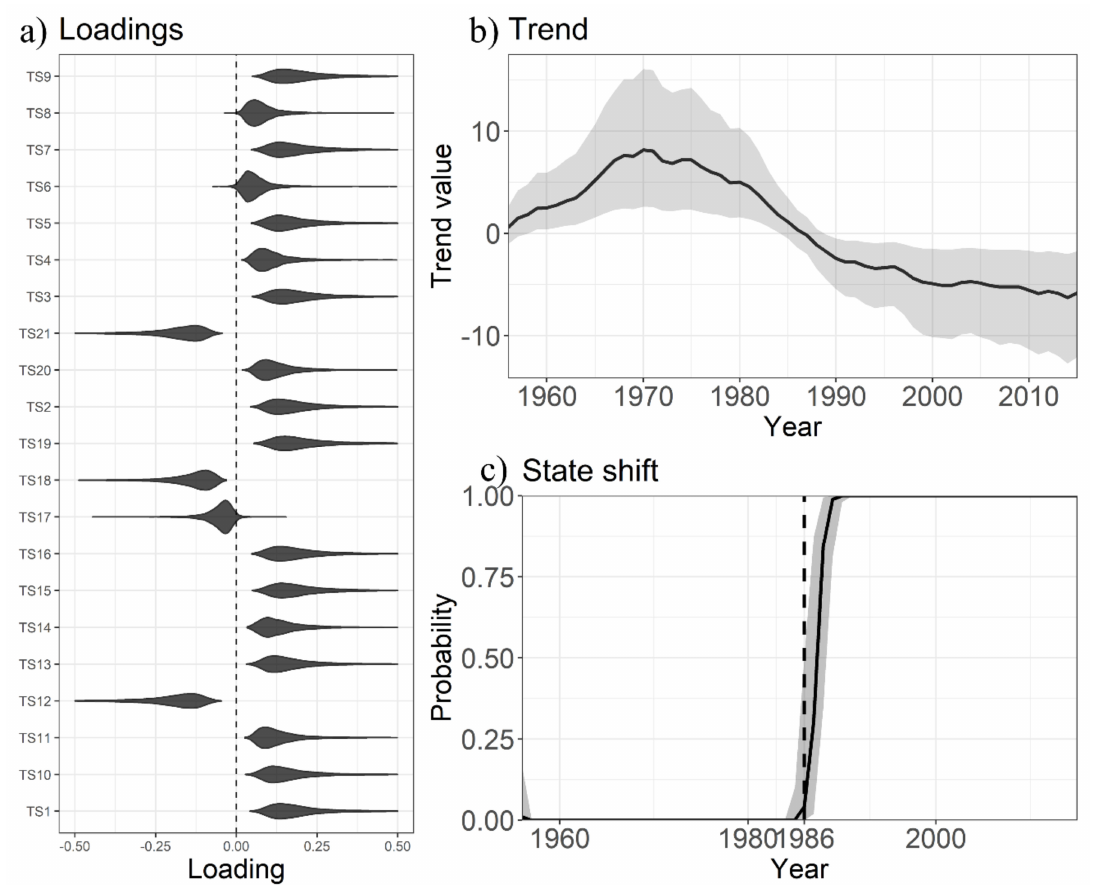
Figure 2. Bayesian DFA and HMM analysis for demersal fishes (1956–2015) in temperate waters of the NWP. ( a ) Posterior distributions for loadings on each time series. ( b ) The shared trend time series with a 95% credible interval. ( c ) State probability of the shared trend (median probability with a 95% credible interval). The dotted line represents the shift